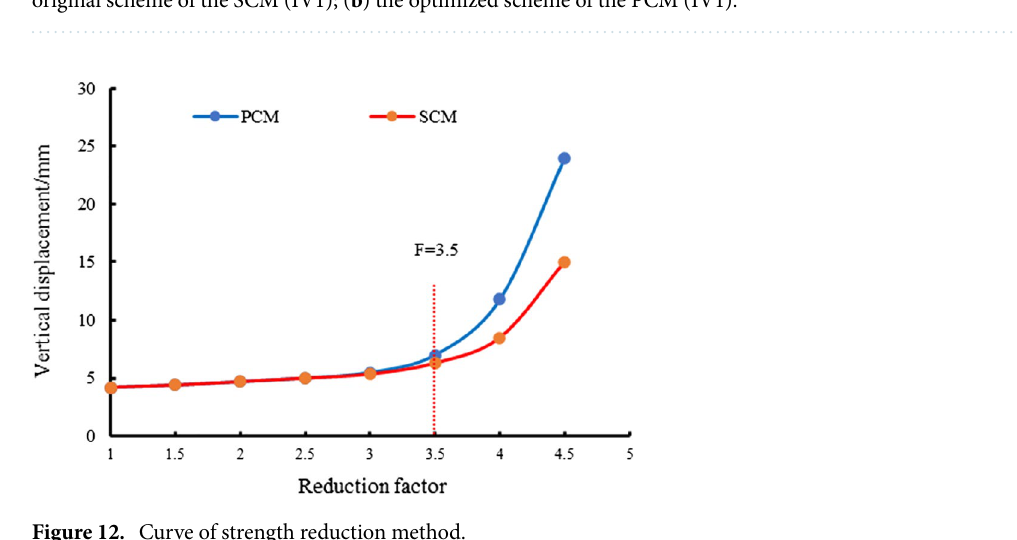
Figure 11. Two types of construction methods: plastic zone and supporting structure force diagram. ( a ) The original scheme of the SCM (IV1); ( b ) the optimized scheme of the PCM (IV1).